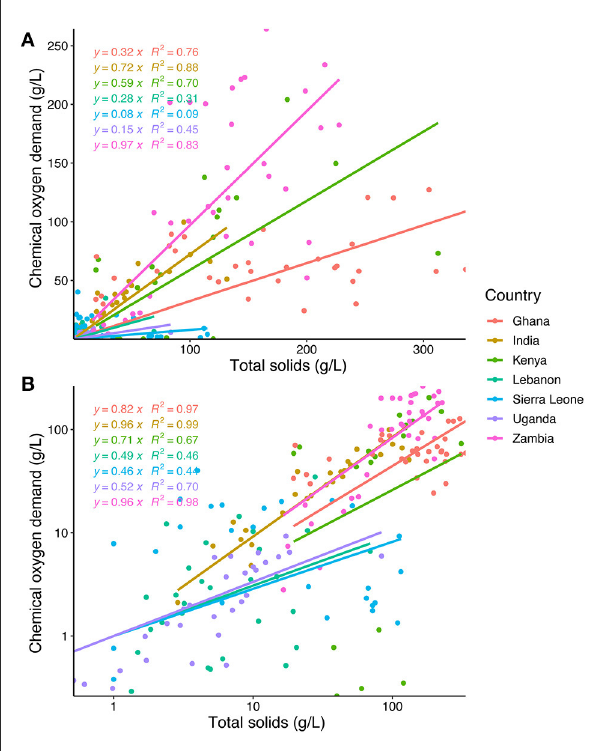
FIGURE7 (A) Linear correlations between TS and COD for each country in this study, with the regression lines forced through the origin. One outlier was removed from the Uganda dataset. (B) Linear correlations between TS and COD on a log10